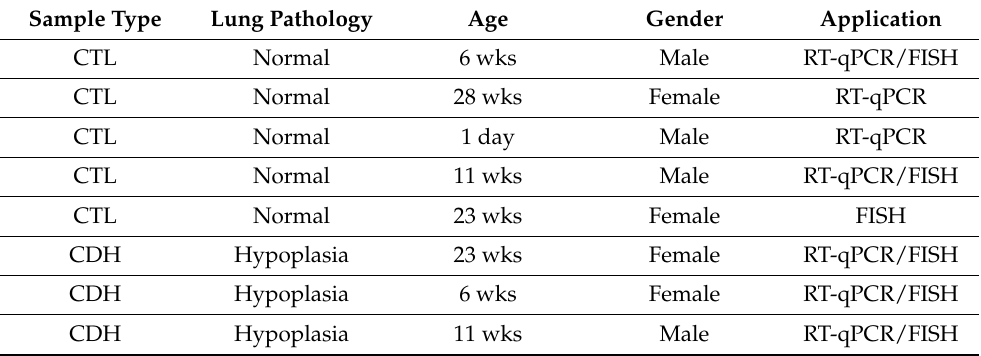
Table 3. Human samples characteristics for HH pathway characterization in